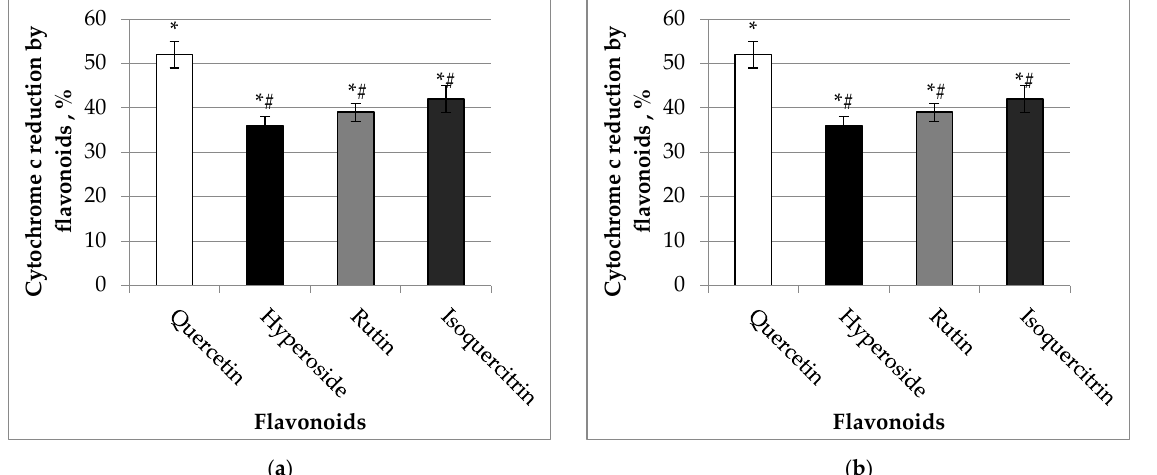
Figure 4. ( a ) Effect of 10 µ M of flavonoids on cytochrome c reduction. ( b ) Effect of 20 µ M of flavonoids on cytochrome c reduction. For the cytochrome c reduction, the spectra of flavonoids were recorded over 500–600 nm and taken as the experimental blanks and then 32 M cytochrome c was added, and the cytochrome c spectrum was recorded every 3 min as described in Material and Methods. The height of absorption peak at 550 nm was taken and compared to the absorption peak of completely reduced cytochrome c (after addition of dithionite) at the end of the test. The effect was calculated according to Formula (3). * Statistically significant difference ( p < 0.05) compared to control (without flavonoids). *# Statistically significant difference ( p < 0.05) compared to the quercetin group.